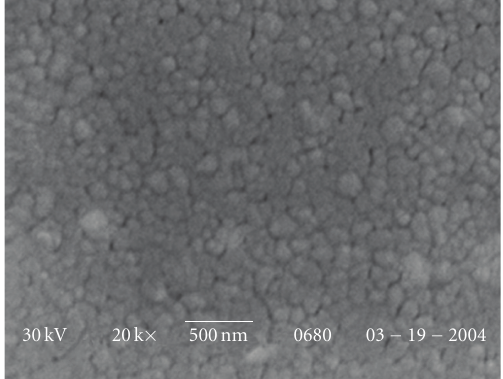
Figure 5: P - E curve of SBTi film annealed deposited by the soft chemical method at 700 ◦ C for 2